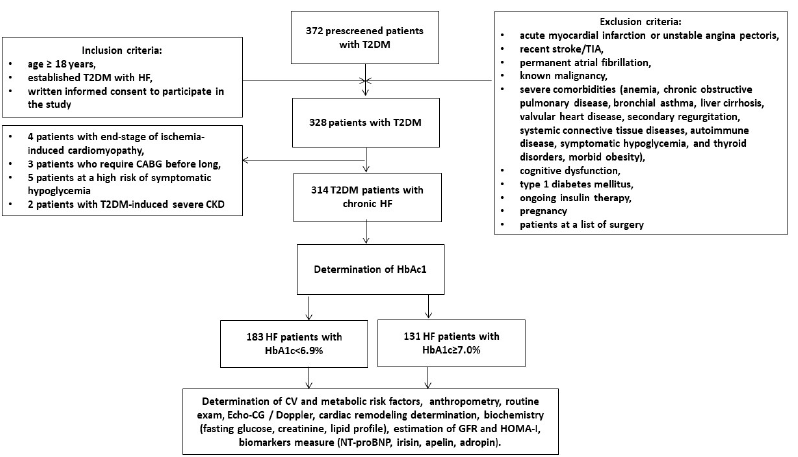
Figure 1. Flow chart of the study design. Abbreviations: CABG, coronary artery bypass grafting; CV, cardiovascular; CKD, chronic kidney disease; GFR, glomerular filtration rate; HF, heart failure; HbA1c, glycated hemoglobin; HOMA-IR, Homeostatic Assessment Model of Insulin Resistance; N-terminal brain natriuretic pro-peptide; T2DM, type 2 diabetes mellitus; TIA, transient ischemic attack.